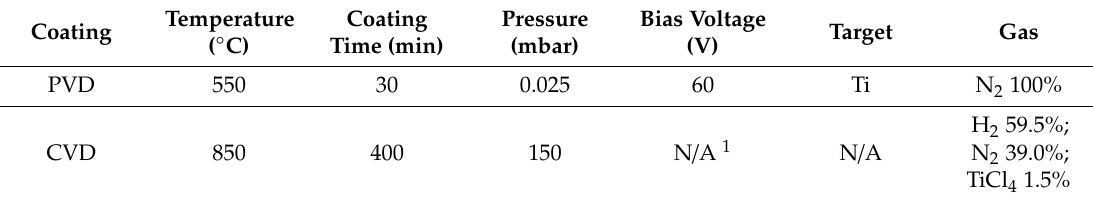
Table 1. Main deposition conditions of physical vapor deposition (PVD) and chemical vapor deposition (CVD) coatings.